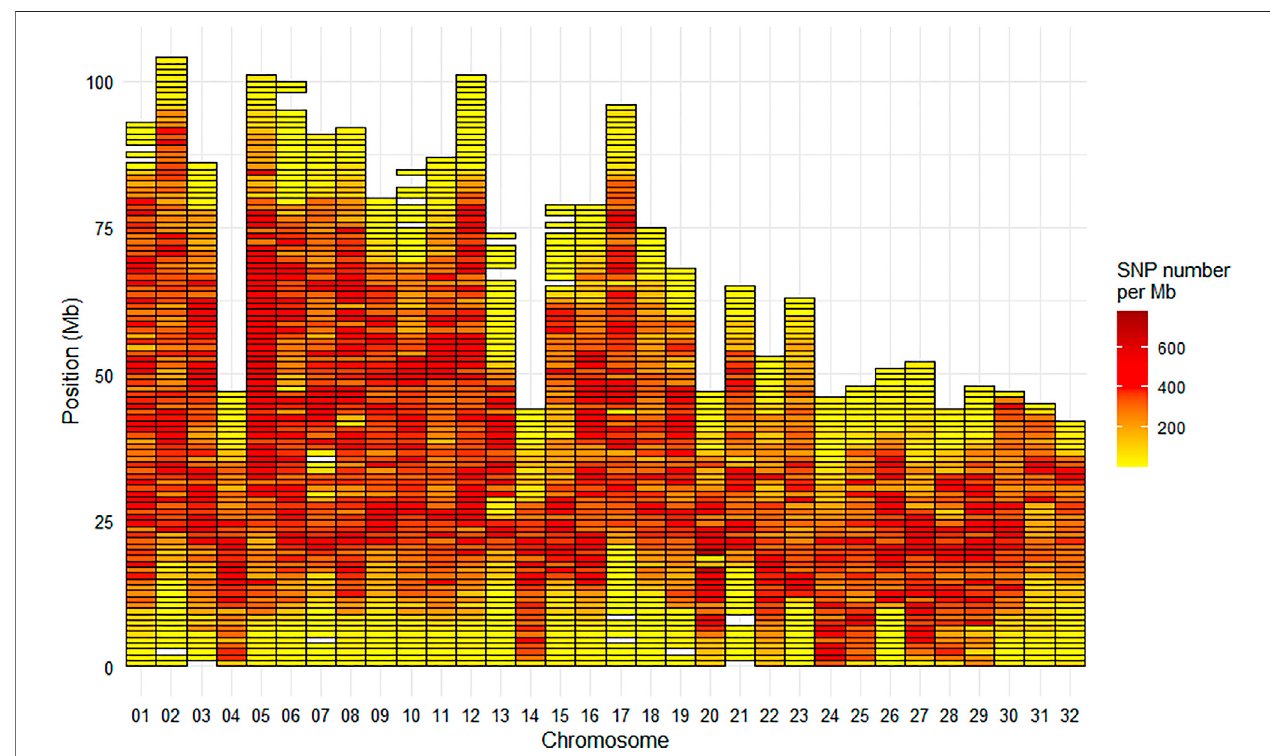
FIGURE 5 | Marker density per Mb for the HD Trout Affymetrix array with 576,118 SNPs positioned on the 32 chromosomes of the Arlee reference genome.